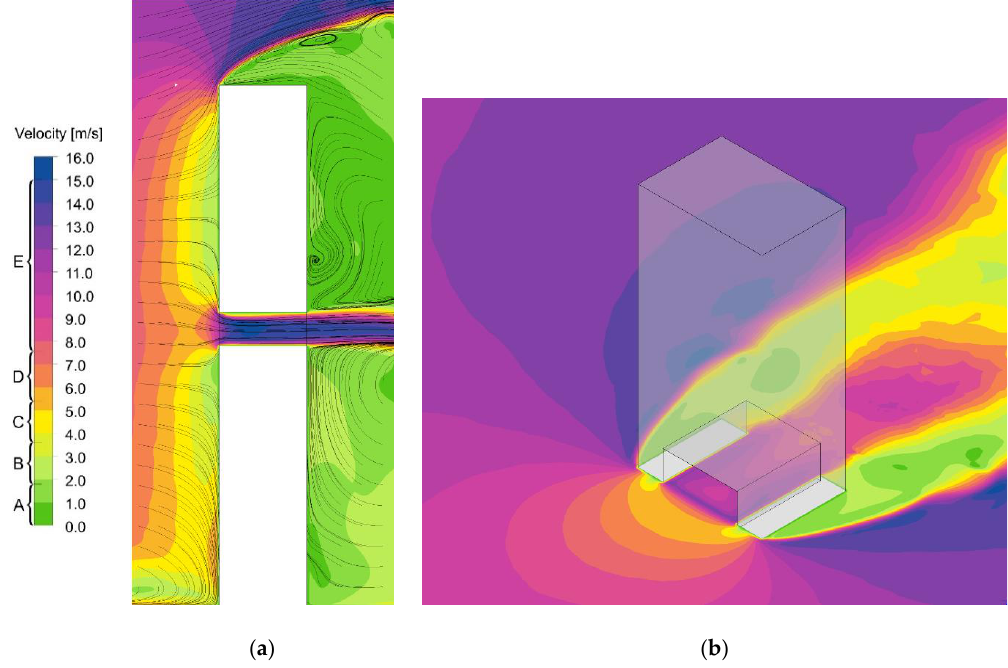
Figure 10. Wind velocity contour around the base skygarden model on ( a ) a central vertical plane through the centre of the skygarden, ( b ) a horizontal plane at occupants’ chest height (1.4 m). A closer observation within the skygarden (Figure 11) indicates that wind speeds are highest near the front, in the range of 10 m/s to 13 m/s. Speeds are generally lower along the middle of the skygarden and increase towards the sides. On average, the velocity at the occupants’ level is 12 m/s, which is significantly higher than the human comfort range. Thus, people will always experience discomfort within the skygarden. Even for intense physical activity, like running, such high wind speeds will be a cause of distress.